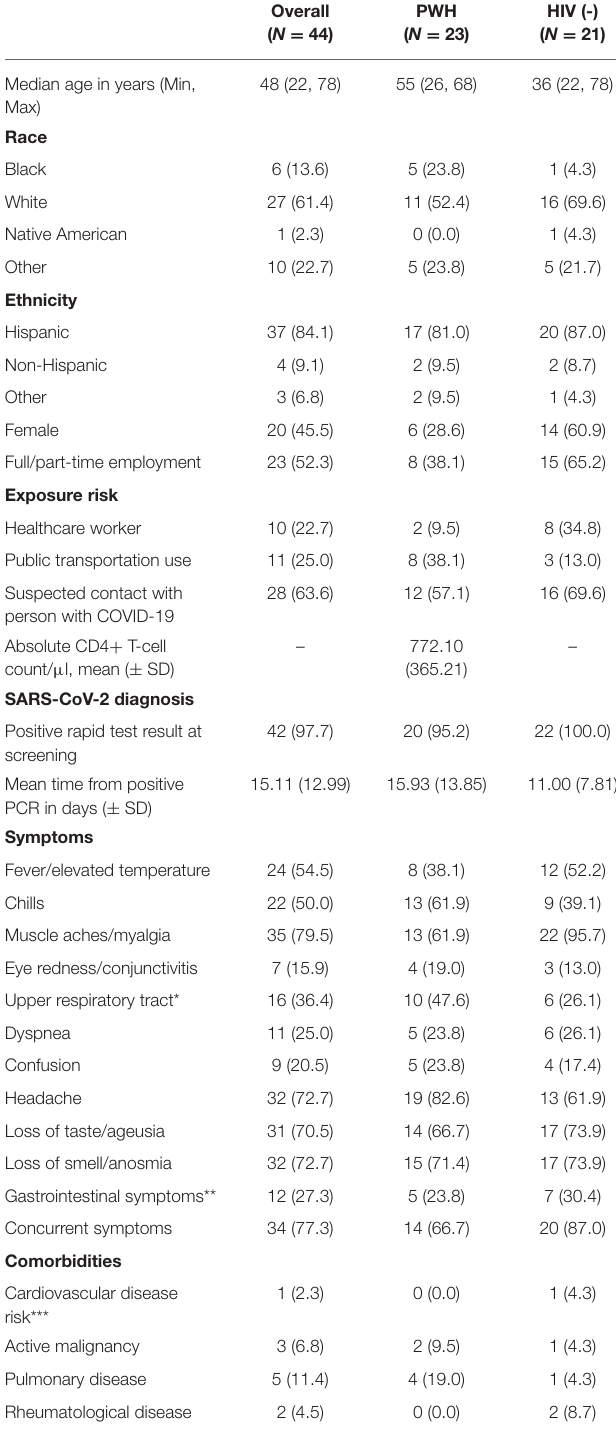
TABLE 1 | Sociodemographic, exposure risk, symptoms, and comorbidities of 44 individuals with SARS-CoV-2 by HIV